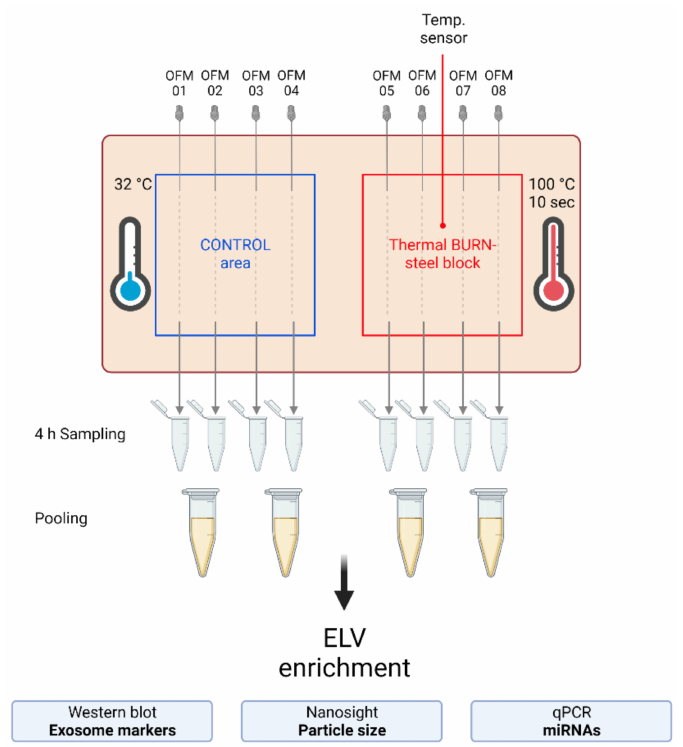
Figure 3. Experimental setup of the dISF sampling with dOFM in an ex vivo human skin model for burn injuries. OFM probes were inserted into ex vivo human skin at the control area (OFM 1–4) and burn area (OFM 5–8), where a steel block of 100 ◦ C was applied for 10 s to provoke a thermal burn. A temperature sensor inserted into the skin enabled the control of temperature at the burn area. OFM was sampled over 4 h. Samples from 2 adjacent probes were pooled. The collected dISF was centrifuged at increasing speeds to enrich ELVs for further